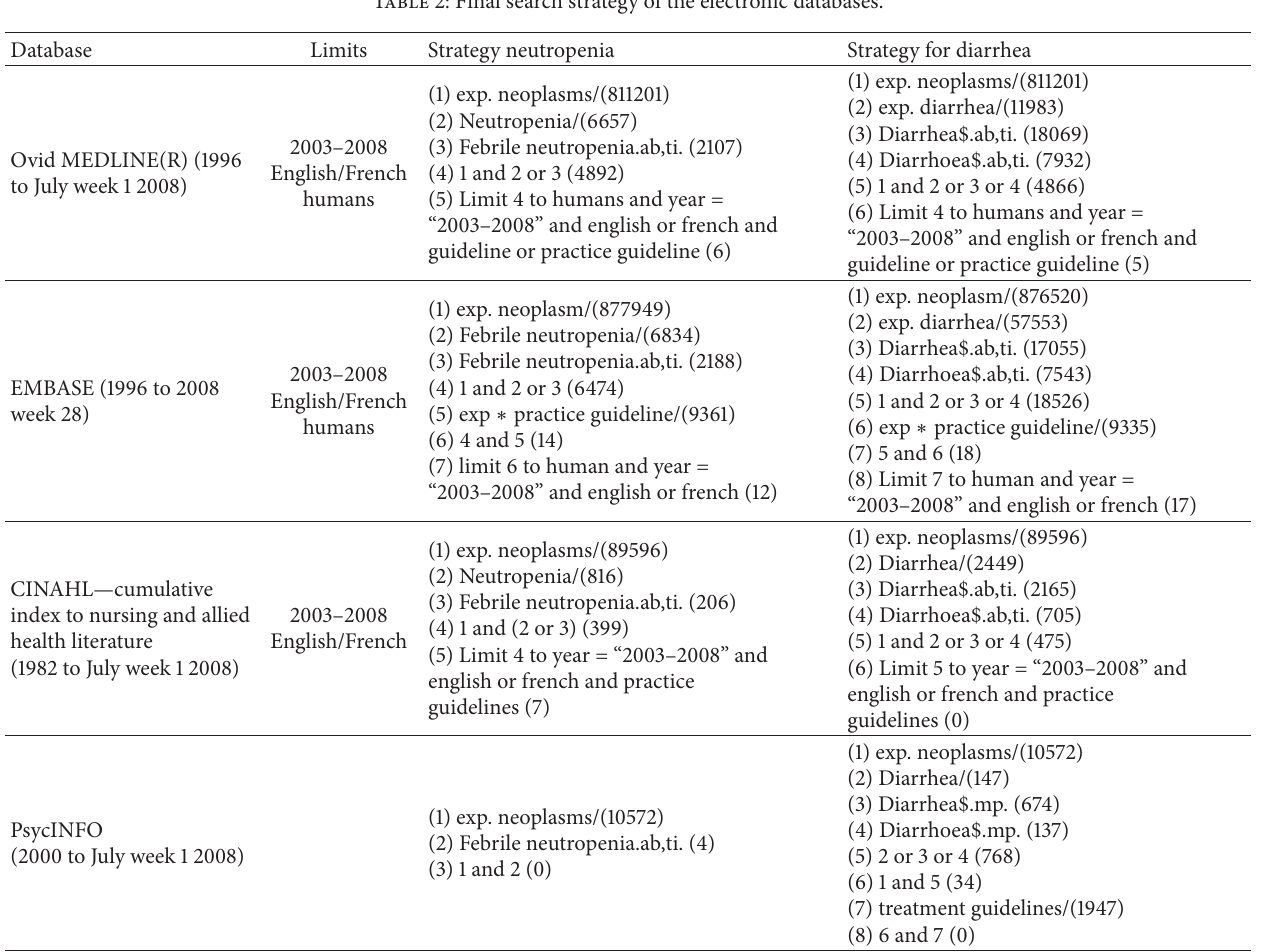
Table 2: Final search strategy of the electronic